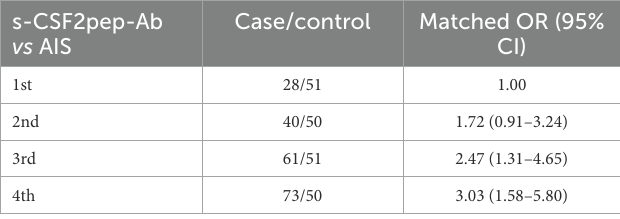
TABLE 6 Analysis of JPHC cohort subjects.